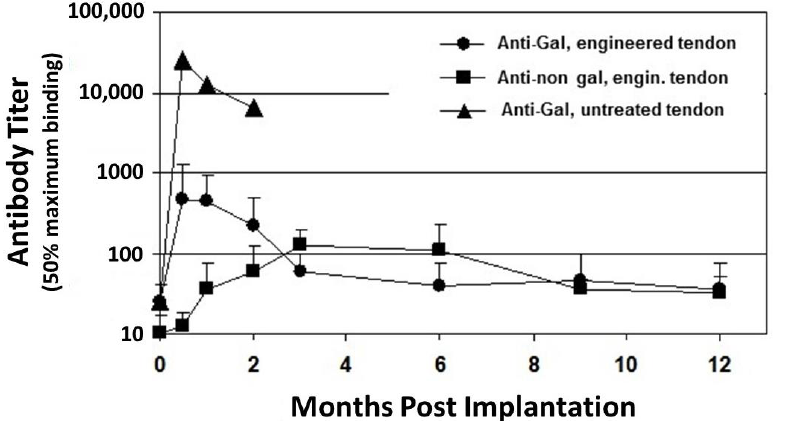
Figure 1. Anti-Gal and anti–non-Gal IgG titers at various time points post implantation of porcine patellar-tendon in rhesus monkeys (n = 13). Anti-Gal titers were measured by ELISA with synthetic α -gal epitopes linked to bovine serum albumin (BSA) as solid-phase antigen. Anti-non gal antibodies measured by ELISA with homogenate of unprocessed porcine patellar-tendon as solid-phase antigen and with sera that were depleted of anti-Gal. The implanted tendon was unprocessed or was a bone-patellar-tendon-bone (BTB) bioprosthesis processed by treatment with recombinant α -galactosidase and partial crosslinking with glutaraldehyde. Error bars represent standard deviation of titers (modified from